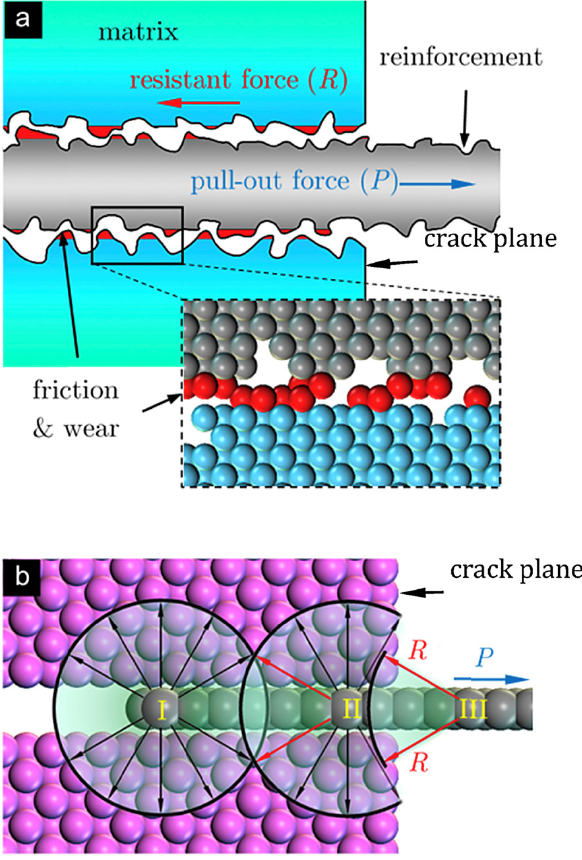
Figure 13: Schematics of (a) a friction-governed micro-/nanofiber pull-out (red areas indicate materials that are friction-damaged during pull-out); (b) crack surface adhesion resistance for ATM during pull-out (circles/arcs indicate the different force equilibria at locations I, II, and III)